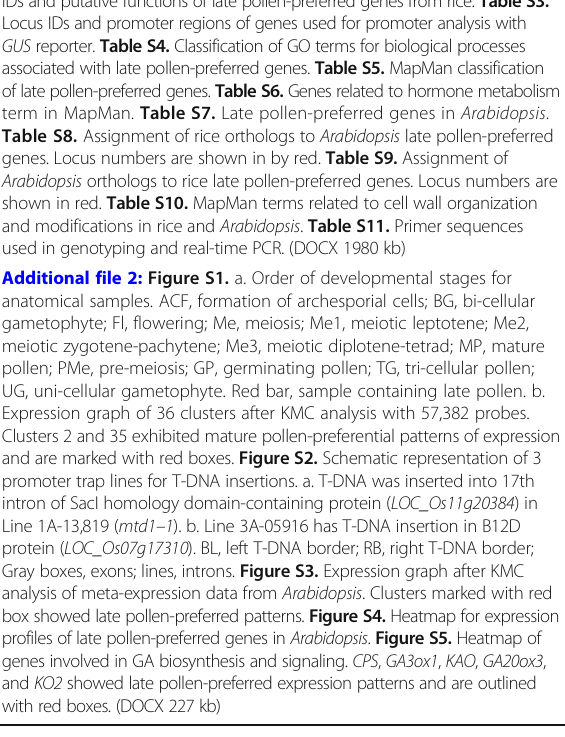
IDs and putative functions of late pollen-preferred genes from rice. Table S3. Locus IDs and promoter regions of genes used for promoter analysis with GUS reporter. Table S4. Classification of GO terms for biological processes associated with late pollen-preferred genes. Table S5. MapMan classification of late pollen-preferred genes. Table S6. Genes related to hormone metabolism term in MapMan. Table S7. Late pollen-preferred genes in Arabidopsis . Table S8. Assignment of rice orthologs to Arabidopsis late pollen-preferred genes. Locus numbers are shown in by red. Table S9. Assignment of Arabidopsis orthologs to rice late pollen-preferred genes. Locus numbers are shown in red. Table S10. MapMan terms related to cell wall organization and modifications in rice and Arabidopsis . Table S11. Primer sequences used in genotyping and real-time PCR. (DOCX 1980 kb) Additional file 2: Figure S1. a. Order of developmental stages for anatomical samples. ACF, formation of archesporial cells; BG, bi-cellular gametophyte; Fl, flowering; Me, meiosis; Me1, meiotic leptotene; Me2, meiotic zygotene-pachytene; Me3, meiotic diplotene-tetrad; MP, mature pollen; PMe, pre-meiosis; GP, germinating pollen; TG, tri-cellular pollen; UG, uni-cellular gametophyte. Red bar, sample containing late pollen. b. Expression graph of 36 clusters after KMC analysis with 57,382 probes. Clusters 2 and 35 exhibited mature pollen-preferential patterns of expression and are marked with red boxes. Figure S2. Schematic representation of 3 promoter trap lines for T-DNA insertions. a. T-DNA was inserted into 17th intron of SacI homology domain-containing protein ( LOC_Os11g20384 ) in Line 1A-13,819 ( mtd1 – 1 ). b. Line 3A-05916 has T-DNA insertion in B12D protein ( LOC_Os07g17310 ). BL, left T-DNA border; RB, right T-DNA border; Gray boxes, exons; lines, introns. Figure S3. Expression graph after KMC analysis of meta-expression data from Arabidopsis . Clusters marked with red box showed late pollen-preferred patterns. Figure S4. Heatmap for expression profiles of late pollen-preferred genes in Arabidopsis . Figure S5. Heatmap of genes involved in GA biosynthesis and signaling. CPS , GA3ox1 , KAO , GA20ox3 , and KO2 showed late pollen-preferred expression patterns and are outlined with red boxes. (DOCX 227